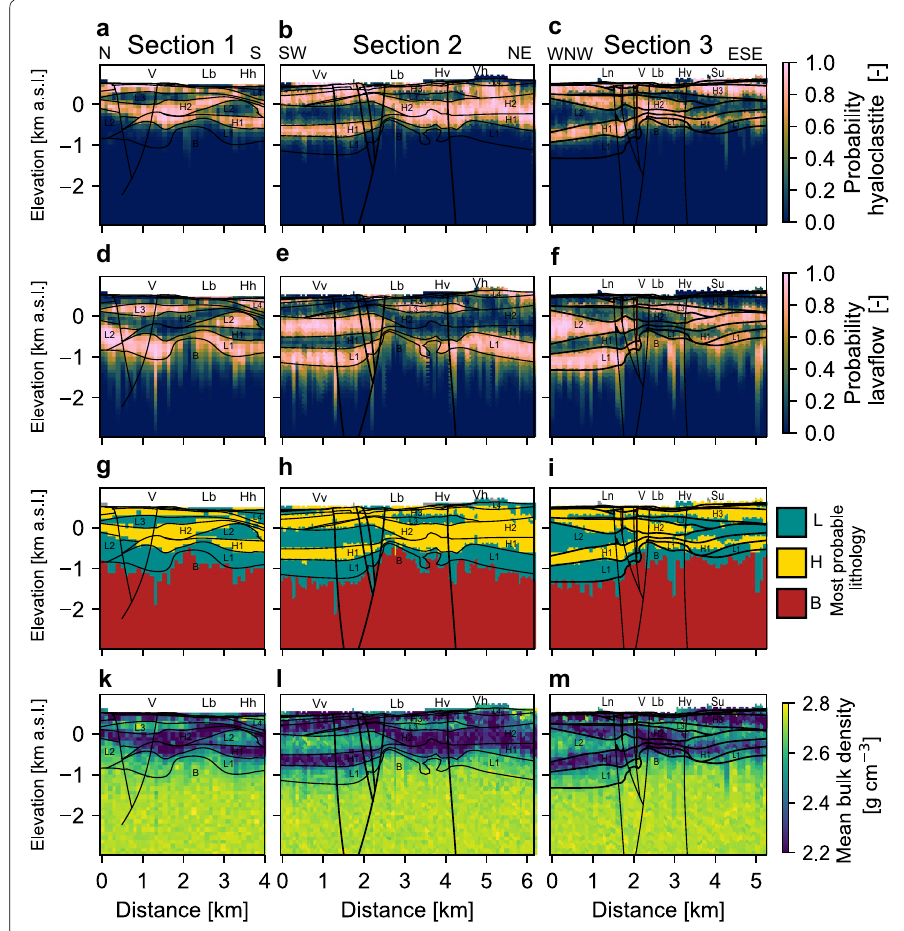
Fig. 10 Posterior results for an inversion run with moderate commonality constraint (Case 3a). Posterior probability of ( a – c ) hyaloclastite, ( d – f ), lava flow, and ( g – i ) most probable lithology and ( k – m ) mean bulk density. Letters at the top of the different sections indicate proximity to different sub-areas of the Krafla field ( V Vitismor, Lb Leirbotnar, Hh Hvitholar, Hv Hveragil, Vh Vesturhlí ð ur, Ln Leirhnjúkur, Su Su ð urhlí ð